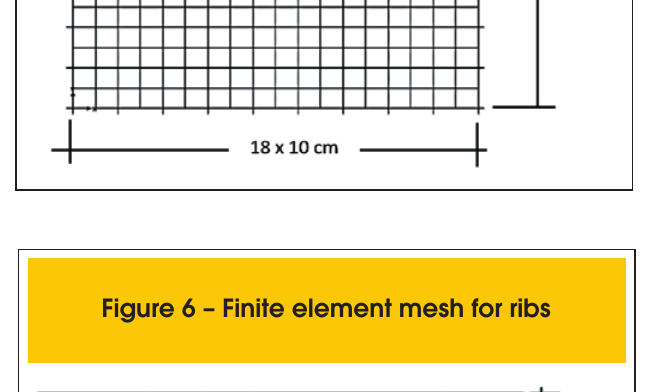
Figure 7 – Stress-strain relationship for tensile concrete –